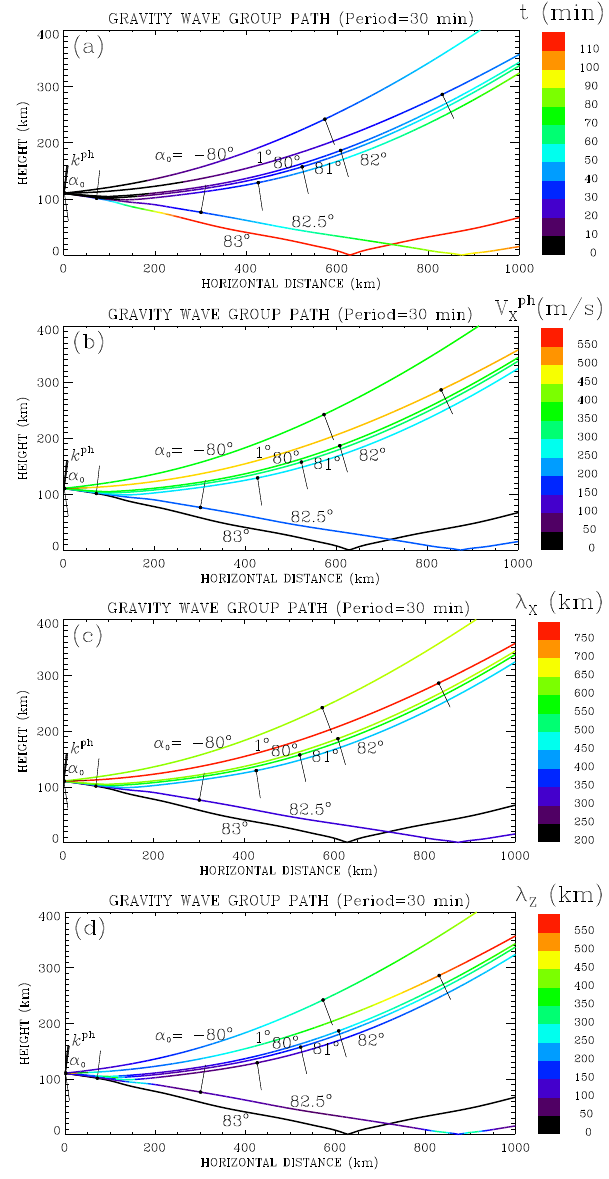
Fig. 2. Ray paths for 30-min period gravity waves in a stationary atmosphere. When the phase propagation direction k ph is upward ( α 0 > 0) the group velocity is downward and vice versa. The rays are the same in all panels, but are colour-coded for time of travel, horizontal wavelength and horizontal phase